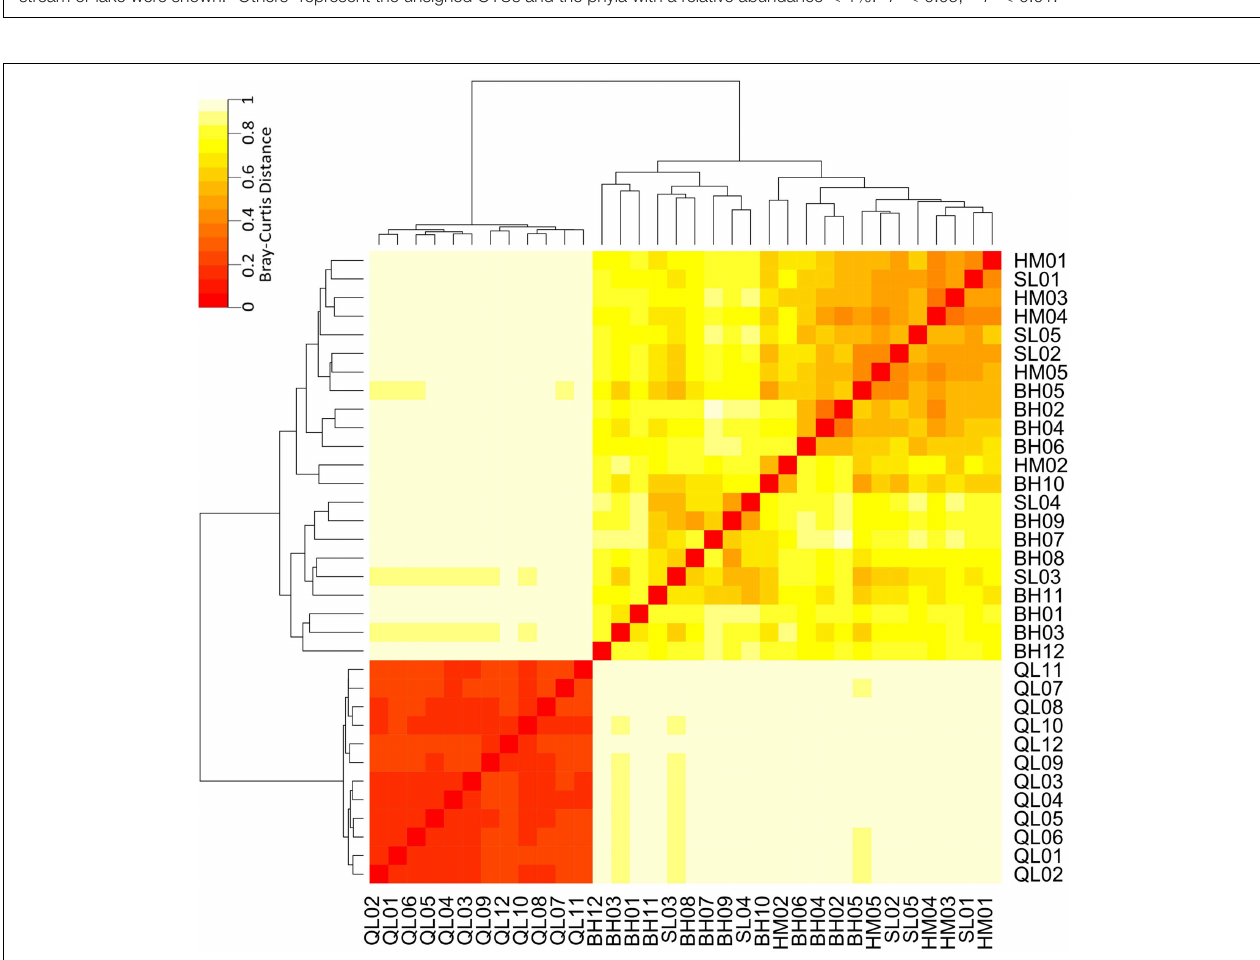
FIGURE 3 | Heatmap showing the taxonomic differences of microbial communities between streams and Qinghai Lake based on Bray–Curtis distance. Bray–Curtis distances were calculated using relative abundances of OTUs.